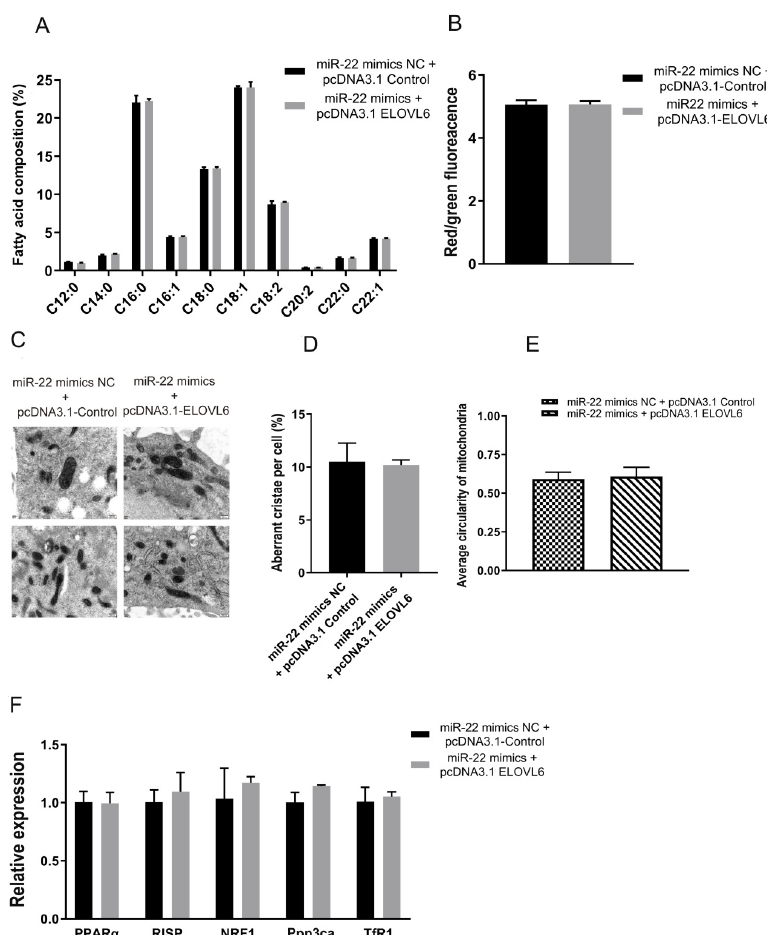
Figure 6. Elongase of very long chain fatty acids 6 (ELOVL6) gene expression reverses the functional changes caused by miR-22. ( A ) Determination of C2C12 cell fatty acid composition by gas chromatography. ( B ) Detection of mitochondrial membrane potential changes by JC ‐ 1. ( C ) Mitochondrial morphology was observed by transmission electron microscope (TEM). ( D ) The percentage of mitochondria with abnormal cristae in each cell was calculated. ( E ) The average circularity of mitochondria was calculated. Scale bar, 200 nm. ( F ) The expression of mitochondrial function ‐ related genes in C2C12 cells after transfection. Data represent mean ± SEM from at least three independent experiments.